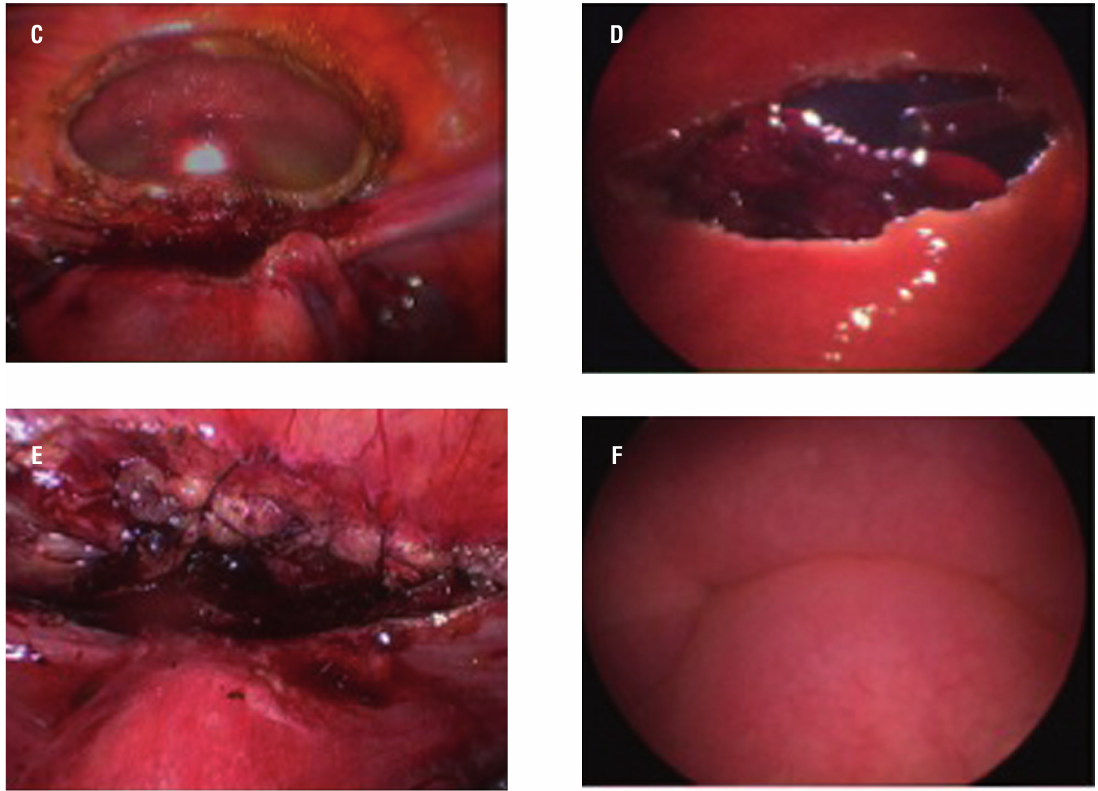
Figure 1E - C e E - Endometriosis ressection and suture in laparoscopic view D e F - Endometriosis ressection and suture in cistoscopic